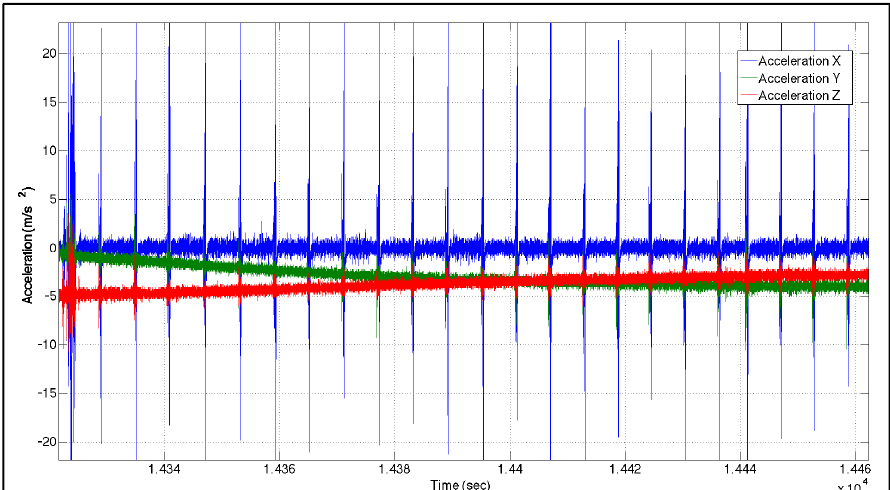
Figure 5. Accelerometer output—LN200.